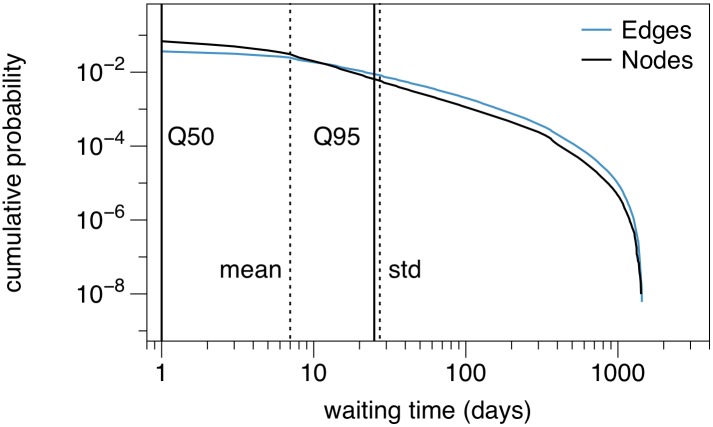
Distribution of node and edge waiting times.The empirical waiting times cover values over three orders of magnitude. Dashed lines show mean and standard deviation of the node waiting times, respectively. Solid lines show median and 95% quantile of the node waiting time distribution.